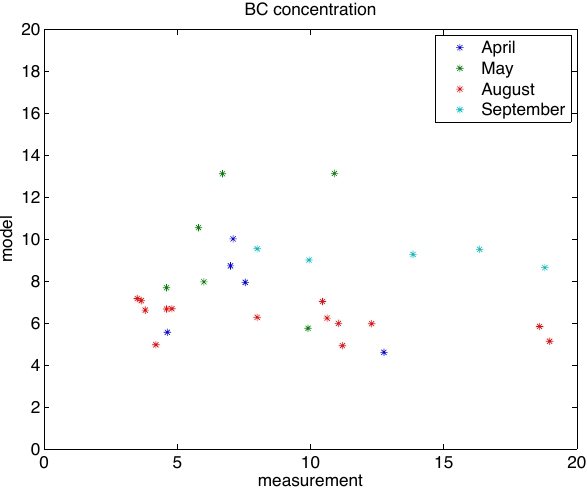
Fig. 3. Model and observed BC concentrations (ngg − 1 ) in the top, surface scattering layer of sea ice or snow on sea ice are compared. Each point represents an average of observations compared with a climatological value for the model grid box that contains those latitude-longitude